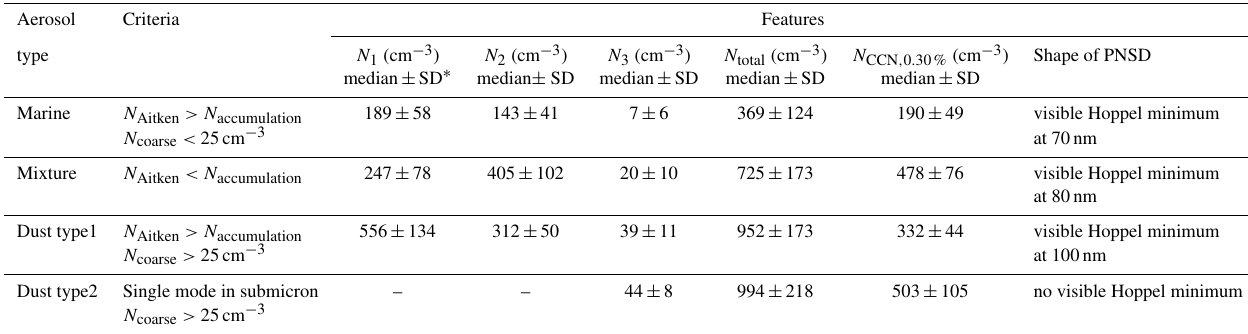
Figure 4. Time series of N Aitken , N accumulation , N coarse , N submicron , sum of N i and N total at CVAO. The different shading colors indicate different aerosol type periods. Table 2. Classification criteria and features of four different particle